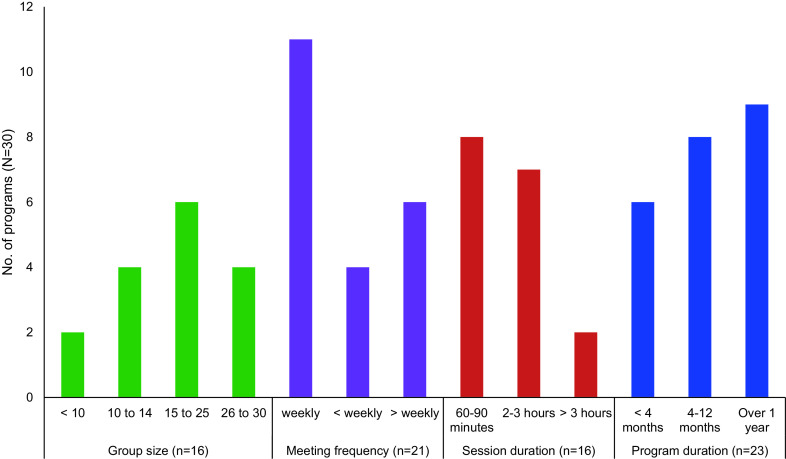
Frequency of Selected Design Features of Community-Based Girl Group Programs